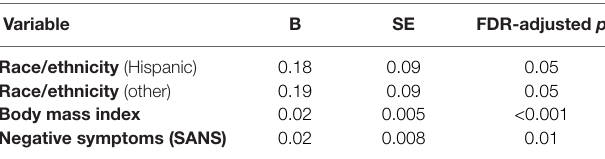
SANS, Scale for the Assessment of Negative Symptoms.